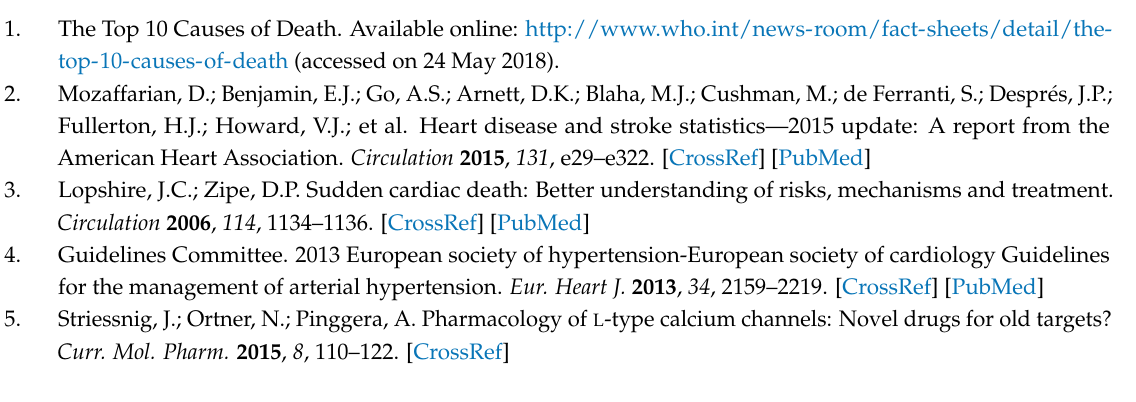
Supplementary Materials: The following are available online. Table S1: Activity of Tested Compounds on K + -depolarized Guinea Pig Vascular Smooth Muscle, NMR spectra of